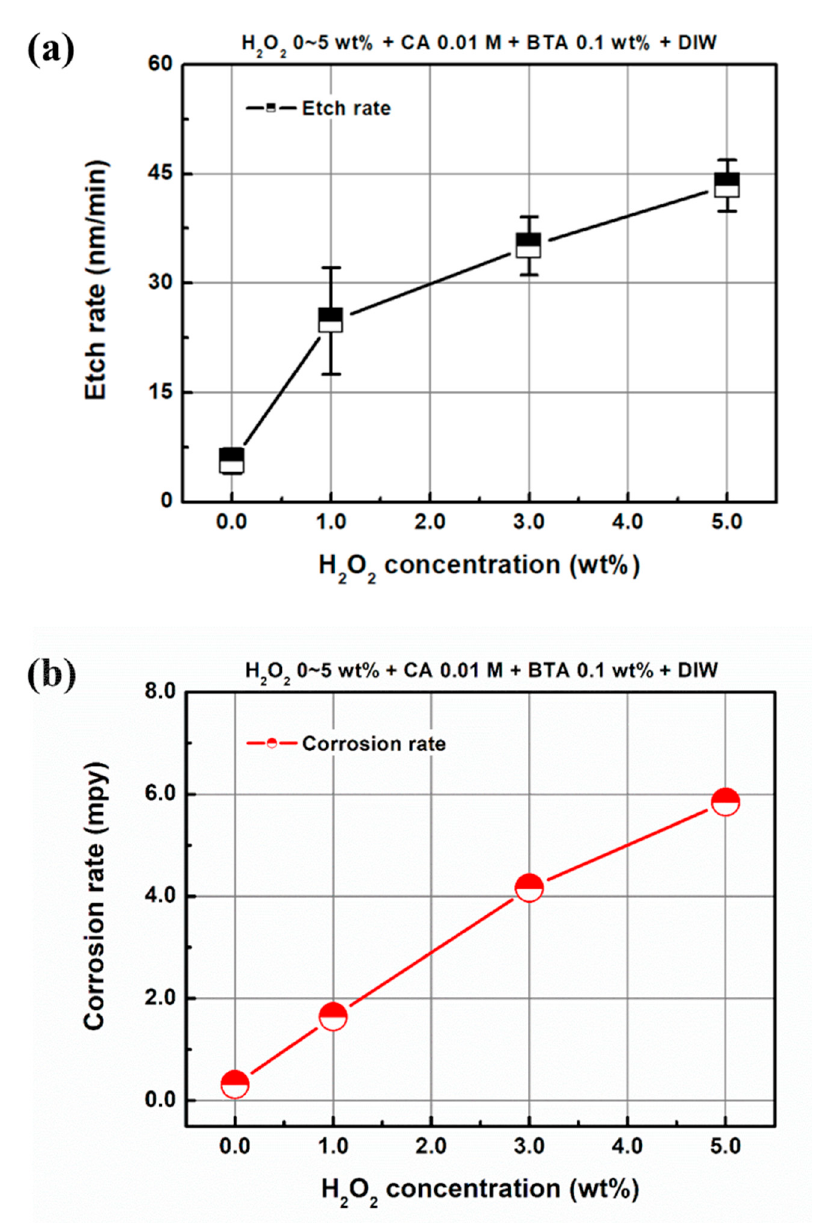
Figure 9. Etch rate and corrosion rate as a function of H 2 O 2 concentration; ( a ) etch rate and ( b ) corrosion rate.